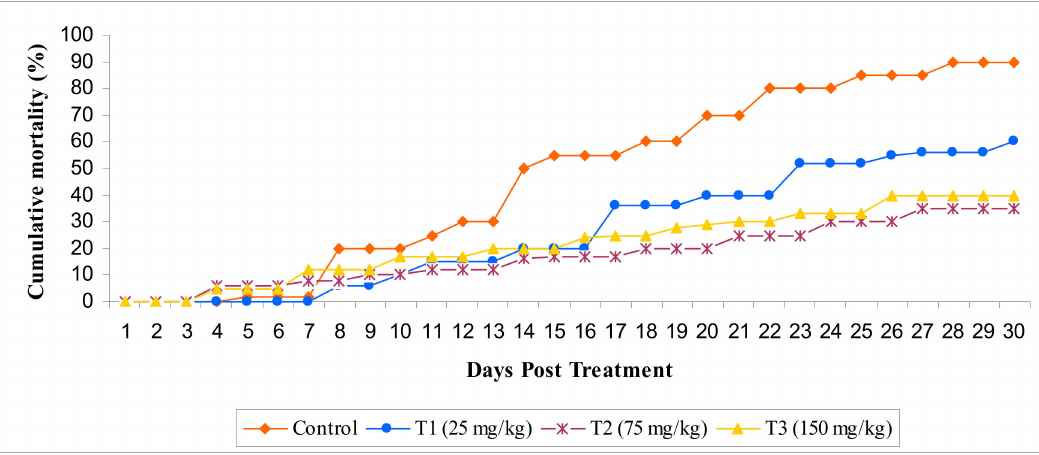
Figure 9. E ff ect of methanol extract of Chaetomorpha antennina administered on the cumulative mortality in Labeo rohita challenged with virulent Edwardsiella